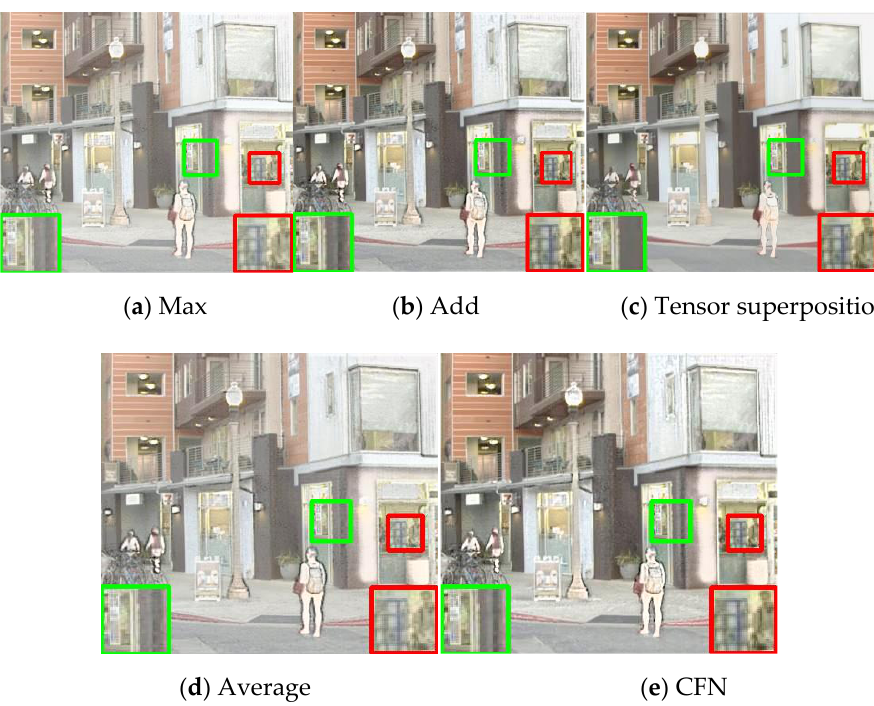
Figure 9. Experimental results of different fusion modules, ( a ) Max, ( b ) Add; ( c ) Tensor superposition; ( d ) Average; ( e ) CFN.